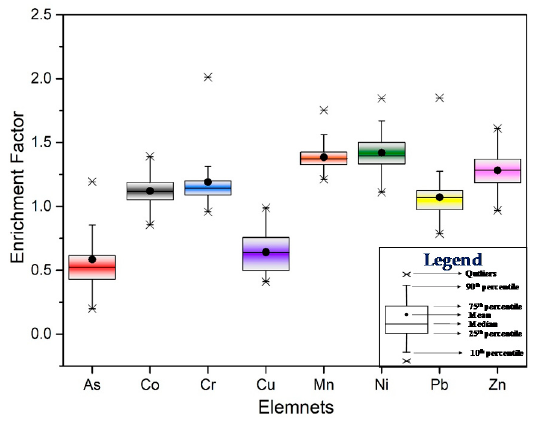
Figure 4. Boxplot of enrichment factors ( EFs ) for PHEs in the study area.